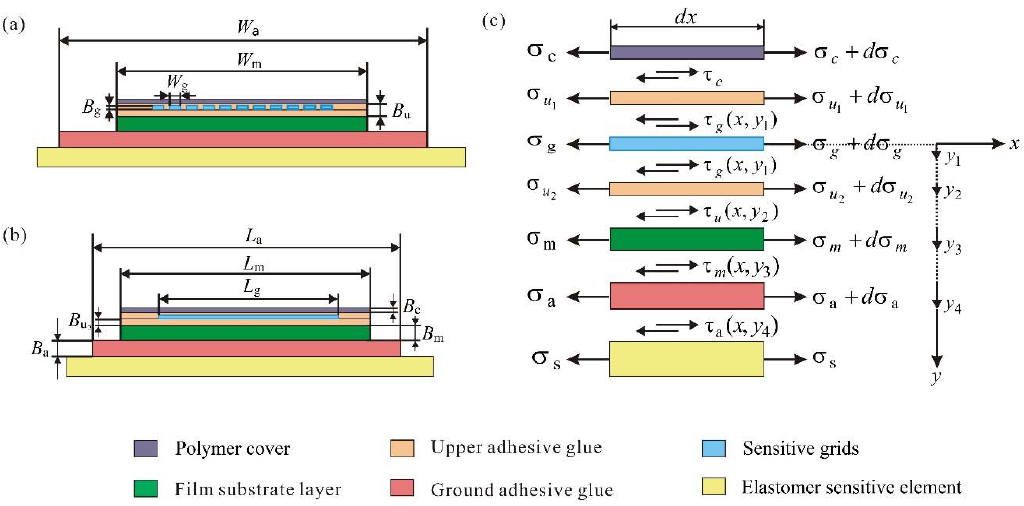
Figure 2. A four-layer and two-glue (FLTG) model of a resistance strain-type transducer. ( a ) The main Figure 2. A four ‐ layer and two ‐ glue (FLTG) model of a resistance strain ‐ type transducer. ( a ) The main view and ( b ) the side view of the FLTG model for a resistance strain-type transducer. ( c ) The strain view and ( b ) the side view of the FLTG model for a resistance strain ‐ type transducer. ( c ) The strain transfer analysis diagram of the resistance strain ‐ type transducer. transfer analysis diagram of the resistance strain-type